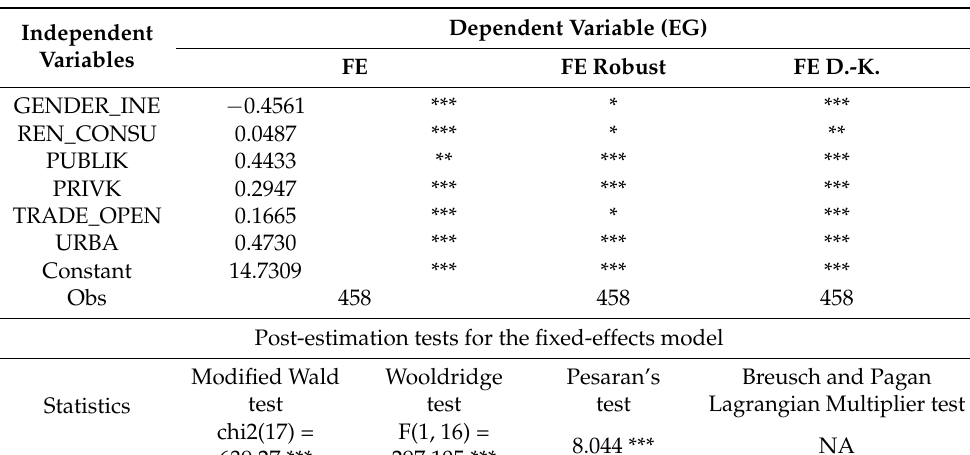
Table 9. The OLS model with fixed effects estimation (main model) and the post-estimation